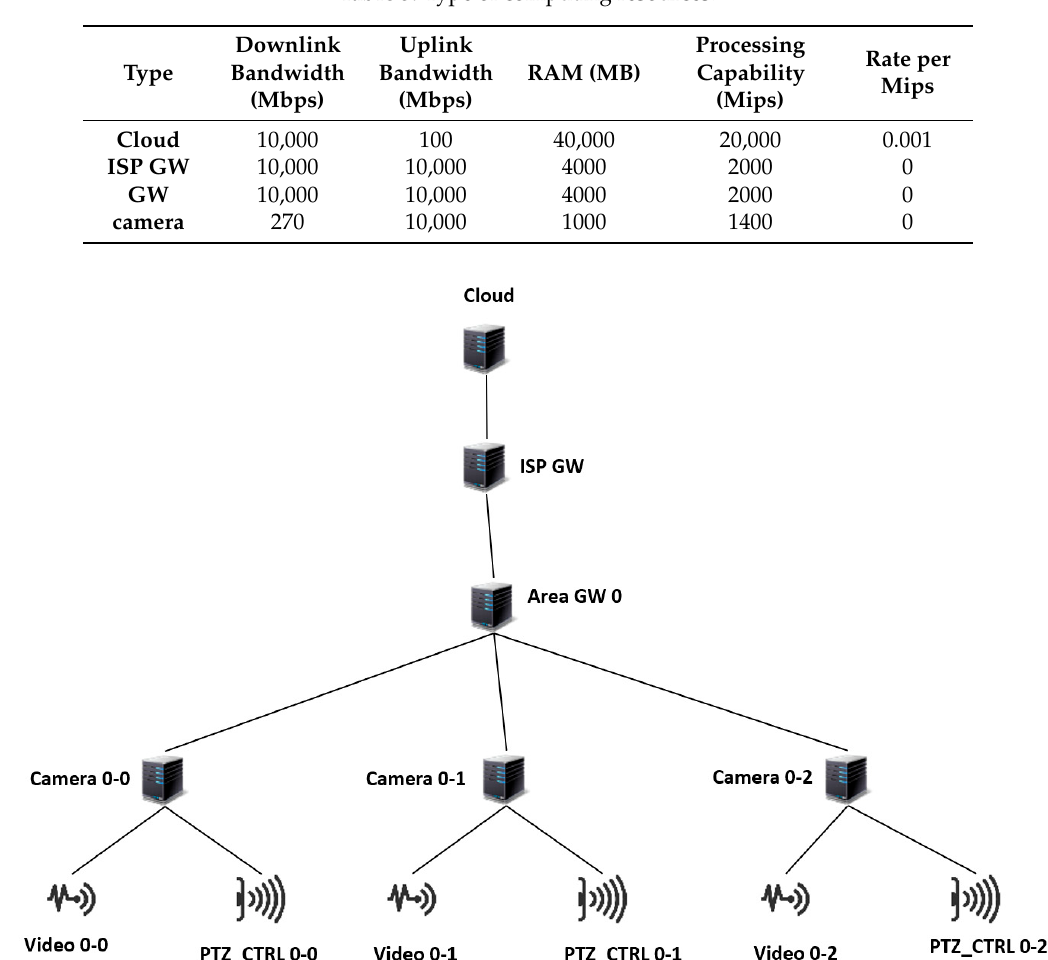
Table 5. Type of computing resources.